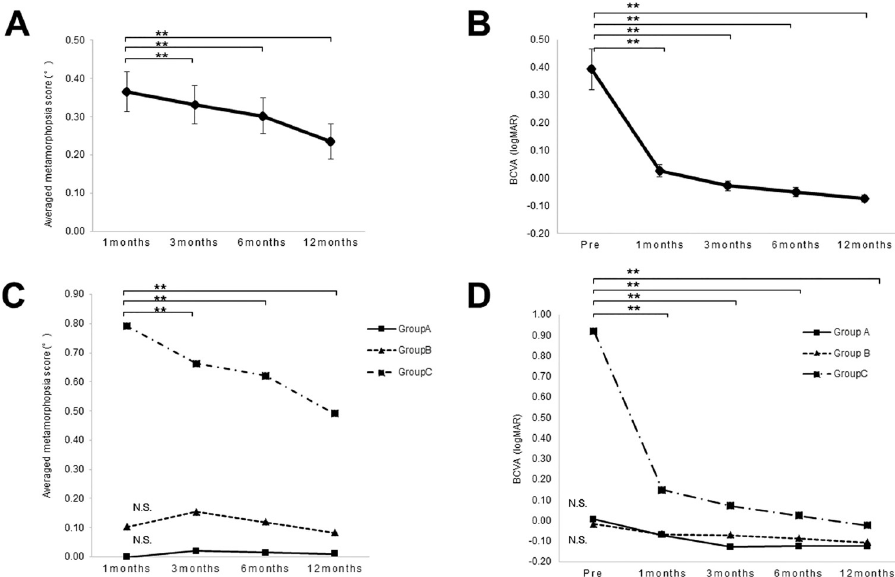
Fig 3. Changes in visual functions of patients after RRD surgery. In all cases, the average metamorphopsia score at 3, 6, and 12 months postoperatively significantly improved from the score at 1 month (p < 0.01) (A). The average metamorphopsia score at 3, 6, and 12 months postoperatively significantly improved from the score at 1 month in Group C (p < 0.01) (C). The average metamorphopsia score did not change throughout the follow-up period in Groups A and B (C). In all cases, BCVA (logMAR) at 1, 3, 6, and 12 months postoperatively significantly improved compared with preoperative BCVA (P < 0.01) (B). BCVA (logMAR) at 1, 3, 6, and 12 months postoperatively significantly improved compared with preoperative BCVA in Group C (P < 0.01) (D). BCVA (logMAR) did not change throughout the follow-up period in Groups A and B